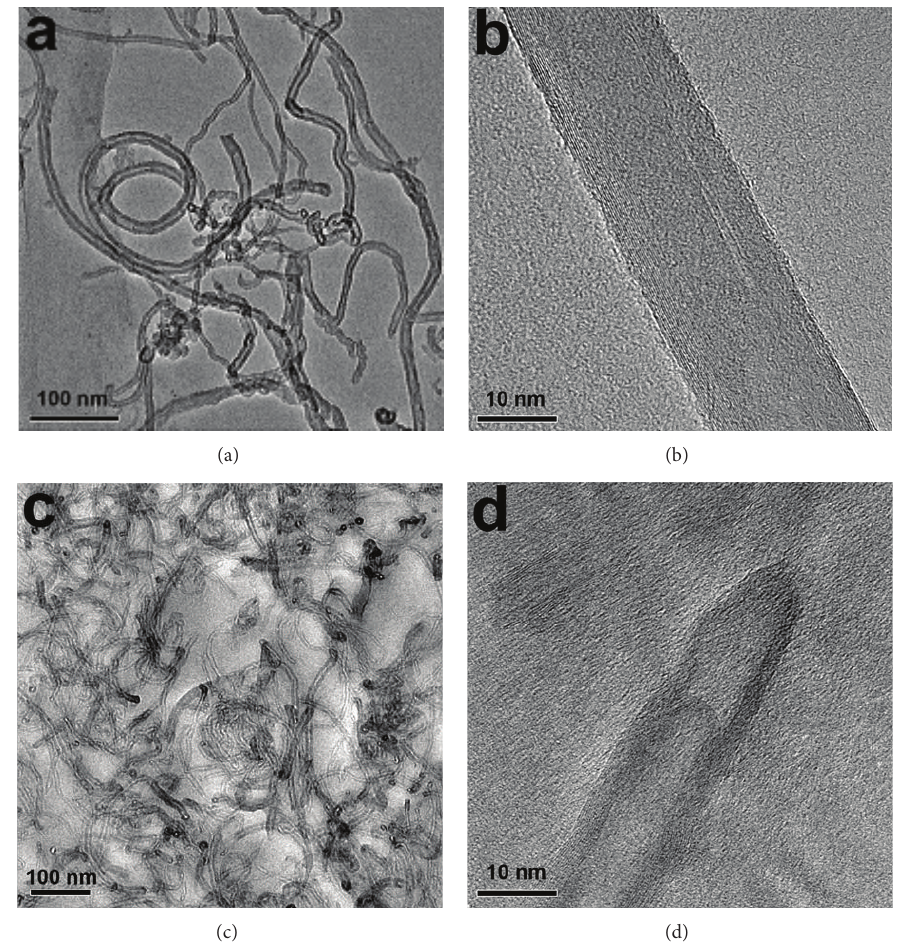
Figure 3: HR-TEM images of the purified MWCNTs ((a), (b)) and the cellulose/MWCNTs hydrogel Gel 5 ((c), (d)).